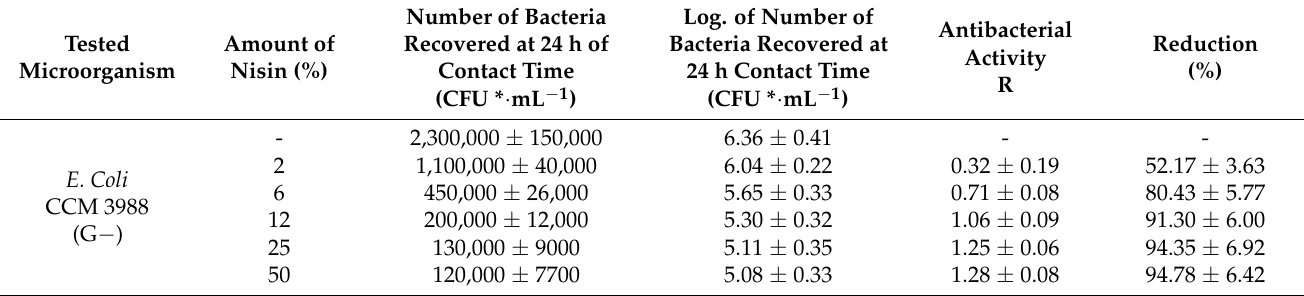
Table 4. The contact method tested both antibody activity and efficiency (quantitative) E. coli CCM 3988 and S. aureus CCM 3953. The concentration of bacteria in the test inoculum was 500,000 CFU·mL − 1 .